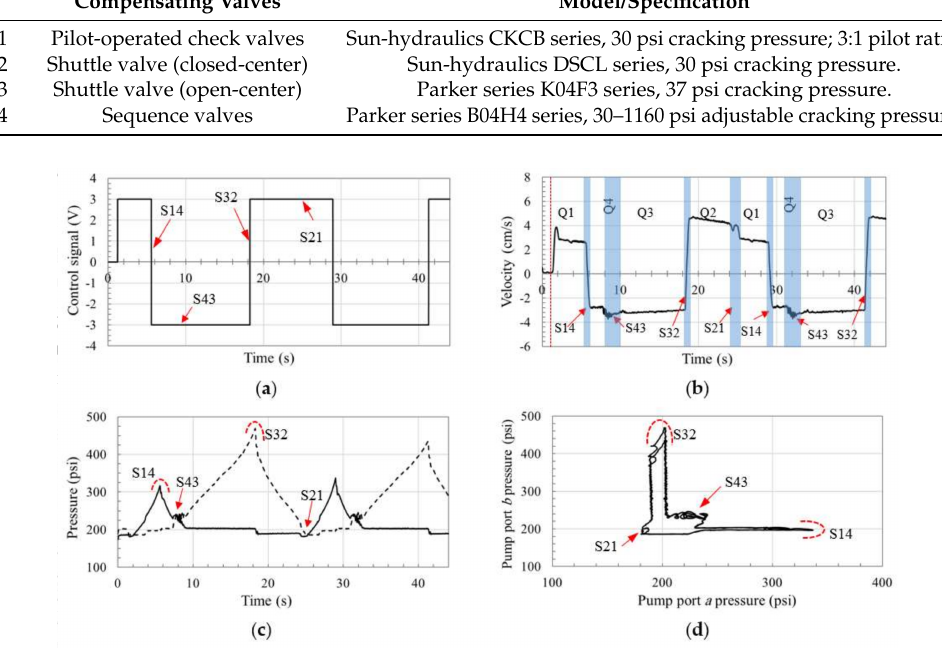
Figure 11. Performance of circuit using POCVs for a 41 kg attached mass: ( a ) control signal; ( b ) actuator velocity; ( c ) pressures at the pump ports a (solid line) and b (dotted line); ( d ) pump pressure plane.